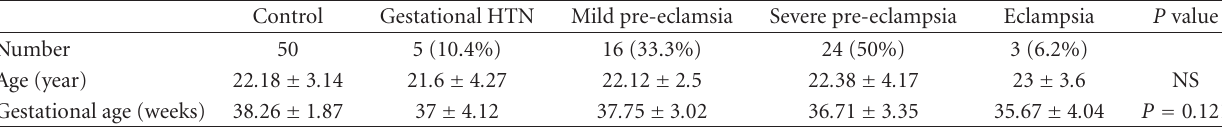
Table 1: Demographic features of healthy pregnant women and women with hypertensive disorders during pregnancy.